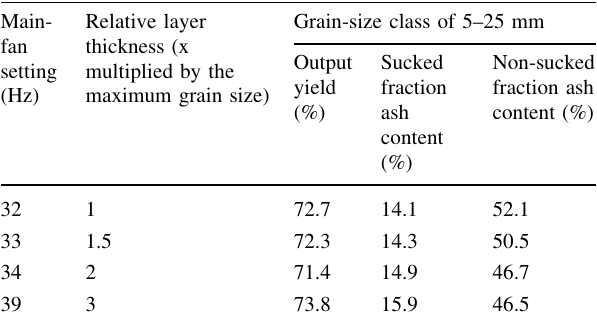
Table 5 Influence of the relative layer thickness on the effectiveness of the separation Main- Relative layer fan thickness (x setting multiplied by the (Hz) maximum grain size)